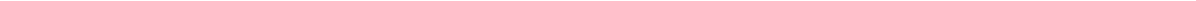
Fig. 5 Activated fi broblasts by miR-1247-3p promote liver cancer progression. a IL-6 and IL-8 secretion from MRC5 expressed miR-1247-3p or control were detected by ELISA assays. b qRT-PCR analysis of stemness-associated genes expression in SMMC-7721 with indicated treatments. c Spheroid formation ability of SMMC-7721 treated with indicated CM. Representative images were shown and spheroid were counted. Scale bar, 150 μ m. d Relative spheroid formation ability of SMMC-7721 treated with indicated CM containing anti-IL-6/anti-IL-8 antibody or IgG control antibody. Representative images were shown. Scale bar, 150 μ m. e qRT-PCR analysis of EMT-associated genes expression in SMMC-7721 with indicated treatments. f Migration assay of SMMC- 7721 treated with indicated CM. Representative images were shown and migrated cells were counted. Scale bar, 150 μ m. g Relative migration ability of